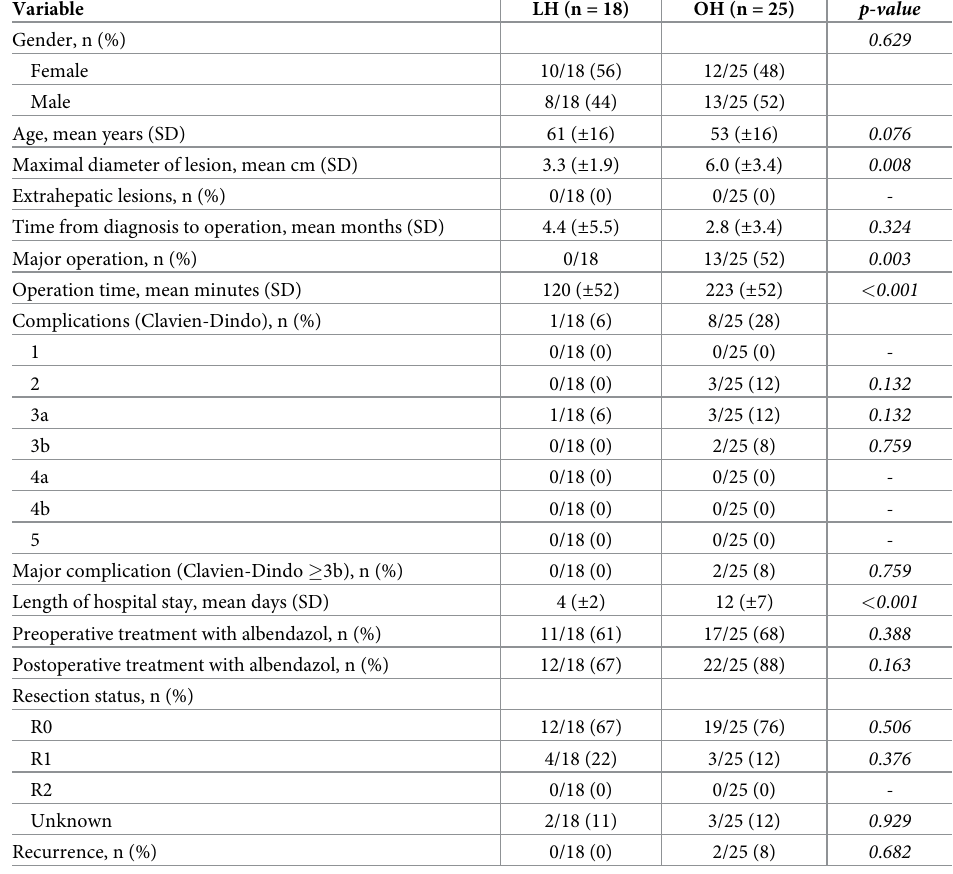
Table 3. Comparison of demographic and perioperative clinical data between laparoscopic and open resection of PNM I staged patients with hepatic alveolar echinococcosis. Variable LH (n =